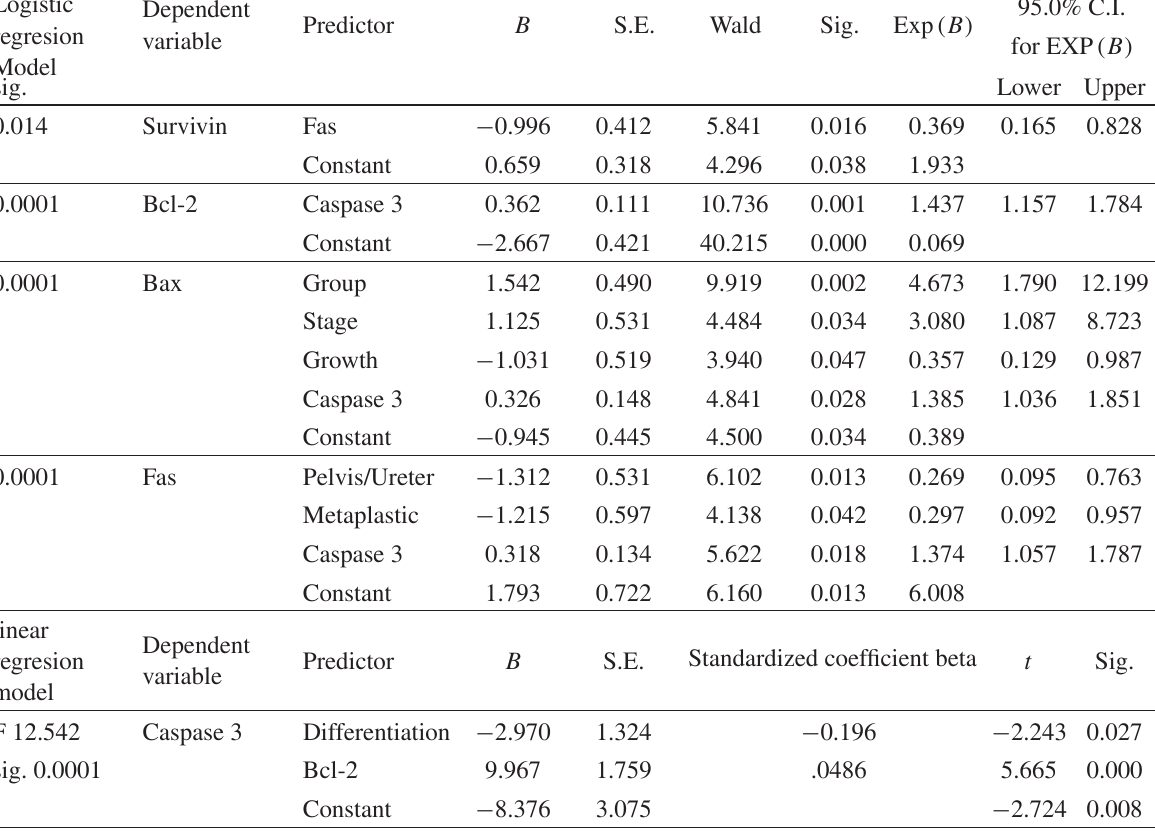
TABLE 4: Multivariate logistic regression and linear regression analysis of all UTUC.